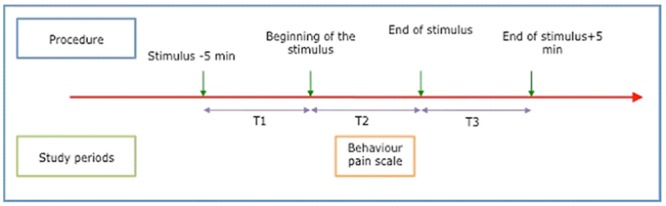
Time-points for ANI measurement.